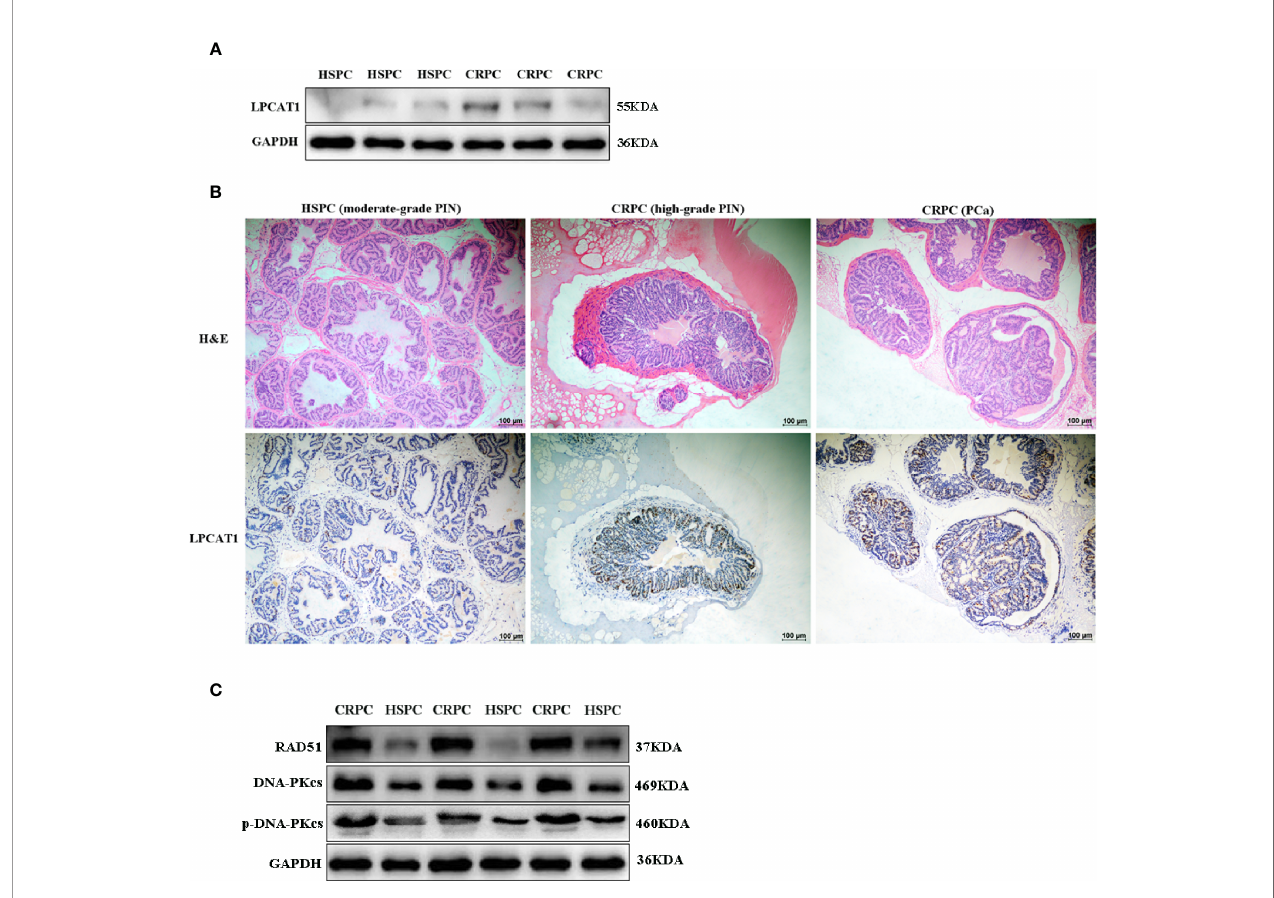
FIGURE 7 | Overexpressed LPCAT1 and DNA repair proteins in mice prostate after FMT with CRPC feces. Both western blots (A) and immunohistochemistry (B) showed that the expression of LPCAT1 was enhanced in mice prostate after FMT with CRPC feces. (C) The expressions of RAD51 and DNA-PKcs were enhanced in mice prostate after FMT with CRPC